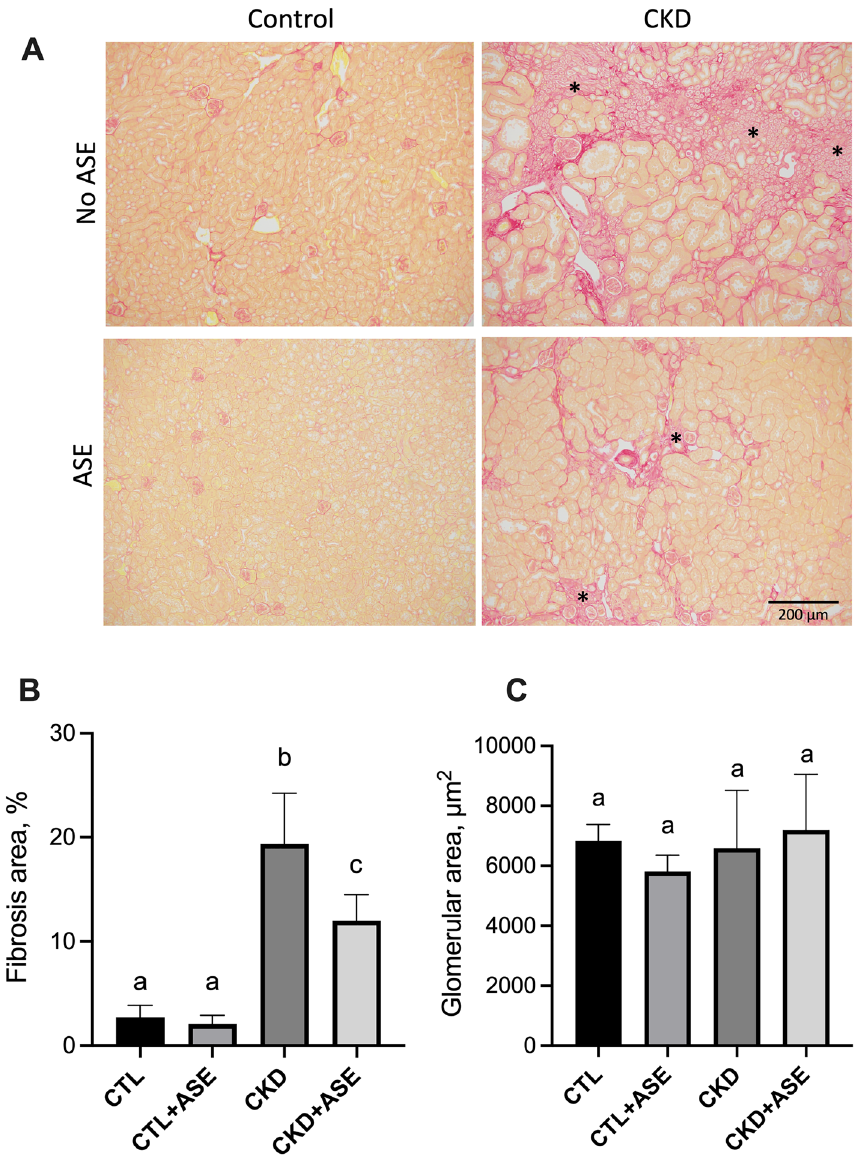
Figure 5. Histological evaluation of kidney fibrosis. ( A ) Typical pictures of fibrotic kidney sections in control and CKD mice. Kidney sections were stained with Sirius Red to evidence collagen deposition. Section viewed under bright field with magnification × 10. ( B ) Sirius red morphometric evaluation in control and CKD mice. ( C ) Mean surface area of glomeruli in control and CKD mice. Significant differences were determined by two-way ANOVA followed by Tukey’s multiple comparison test. Data are expressed as mean ± SD for n = 8–10 animals in each group. Different letters indicate a significant difference between groups at the P < 0.05